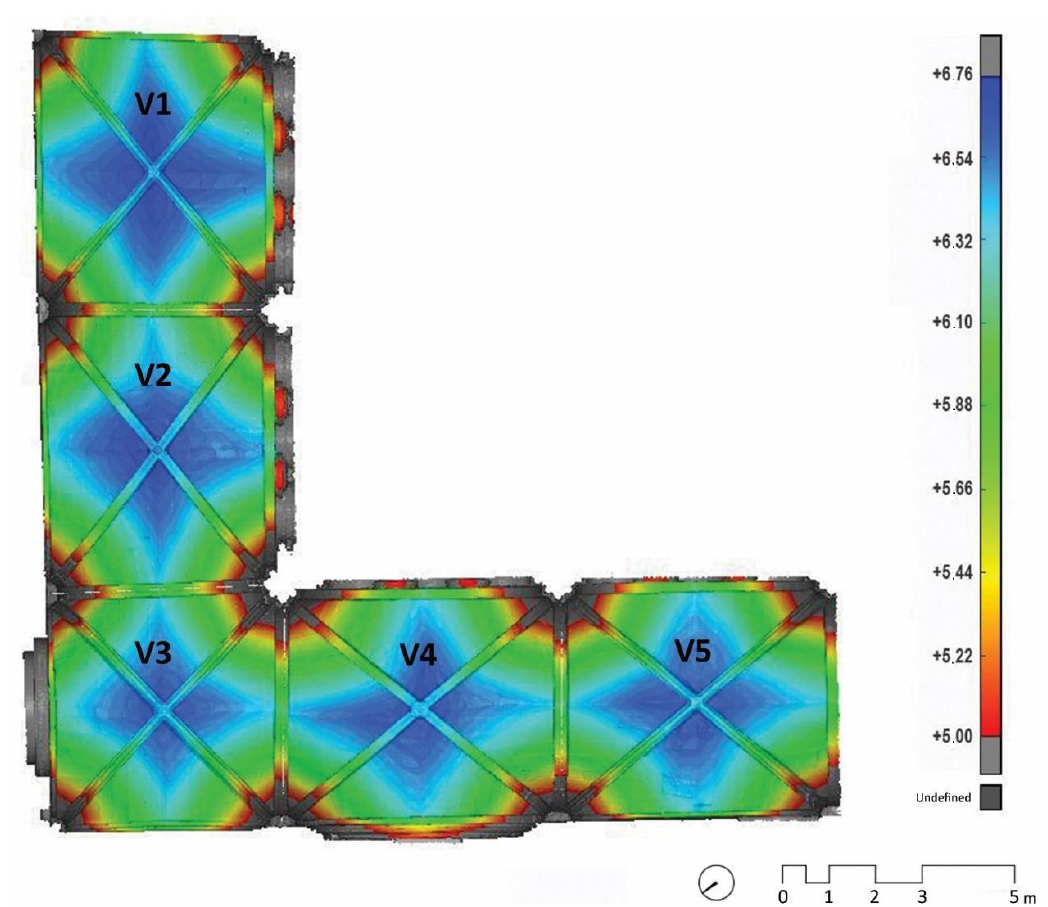
Figure 12. Distance maps between reference horizontal plane and point clouds (units in meters).